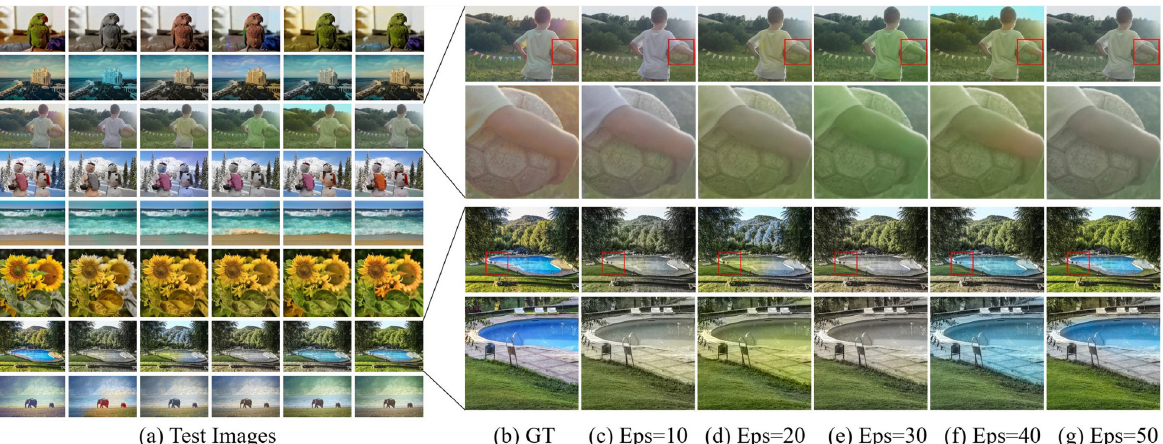
Fig 3. Comparison of coloring effects under different epochs. The full name of GT is the ground truth, that is, is also the source image. The full name of Eps is Epochs. For convenience, the following image subtitles will use GT instead of the ground truth.